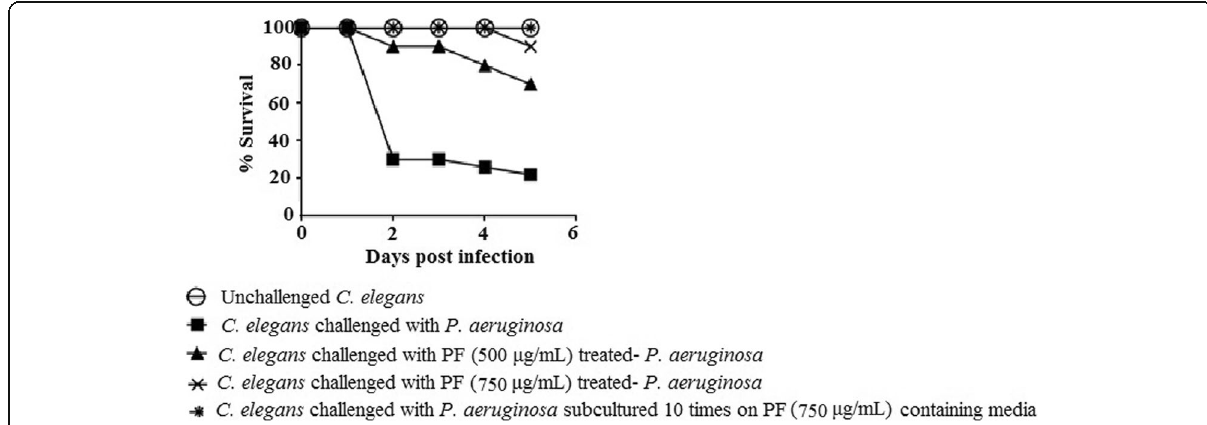
Fig. 2 Survival curve showing the protective effect of PF (750 μ g/mL) on C. elegans , when challenged with P. aeruginosa. Catechin (50 μ g/mL) and Gentamicin (0.1 μ g/mL) employed as positive controls conferred 100 and 80% protection respectively. DMSO present in the ‘ vehicle control ’ at 0.5%v/v neither affected virulence of the bacterium towards C. elegans , nor showed any toxicity towards, worm